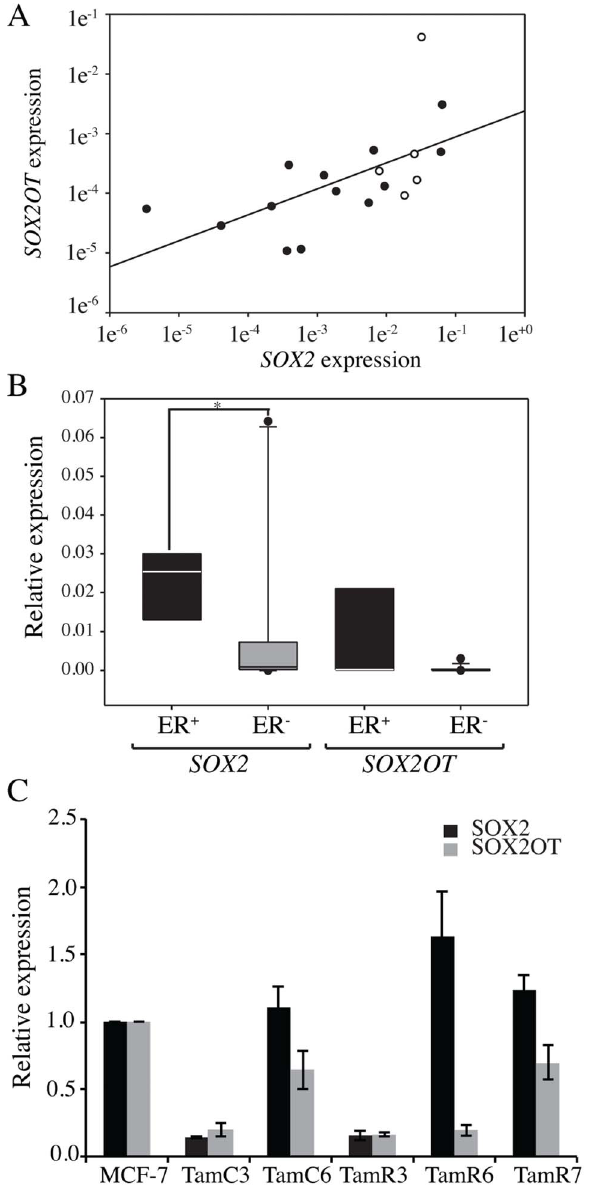
Figure 2. Expression of SOX2 and SOX2OT in different breast cancer cell lines. A) The expression of SOX2 and SOX2OT relative to HPRT and GAPDH in 18 breast cell lines measured by qRT-PCR. Scatter plot showing the expression of SOX2 and SOX2OT . Black and white circles represent ER 2 and ER + cell lines. B) Box plot indicating expression of SOX2 and SOX2OT in ER + and ER 2 breast cancer cell lines. * represents p value , 0.05. C) Expression of SOX2 and SOX2OT in five MCF-7 sub-lines relative to the MCF-7 parental line was measured by qRT-PCR. Error bars represent standard deviations of three technical